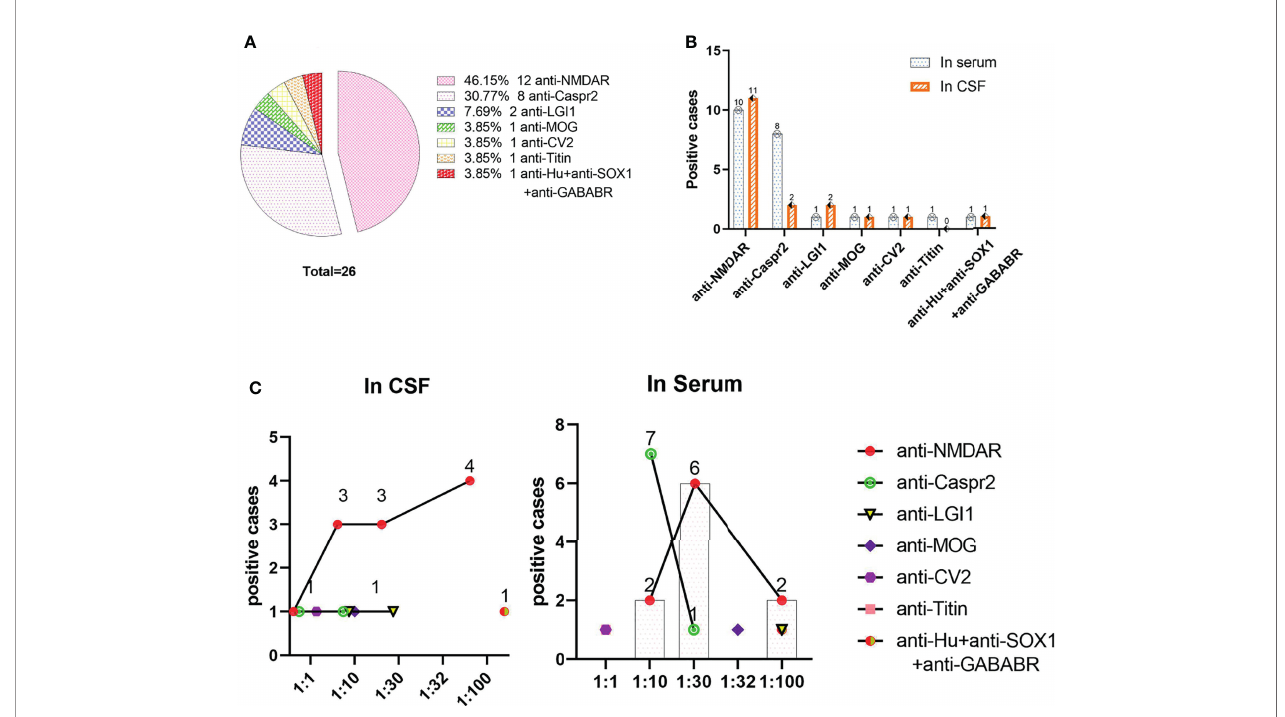
FIGURE 3 | Distributions of positive antibodies and antibody titers. (A) Distributions of positive antibodies; (B) Detection of positive antibodies in serum and/or CSF; (C) Corresponding titers of various antibodies in serum and